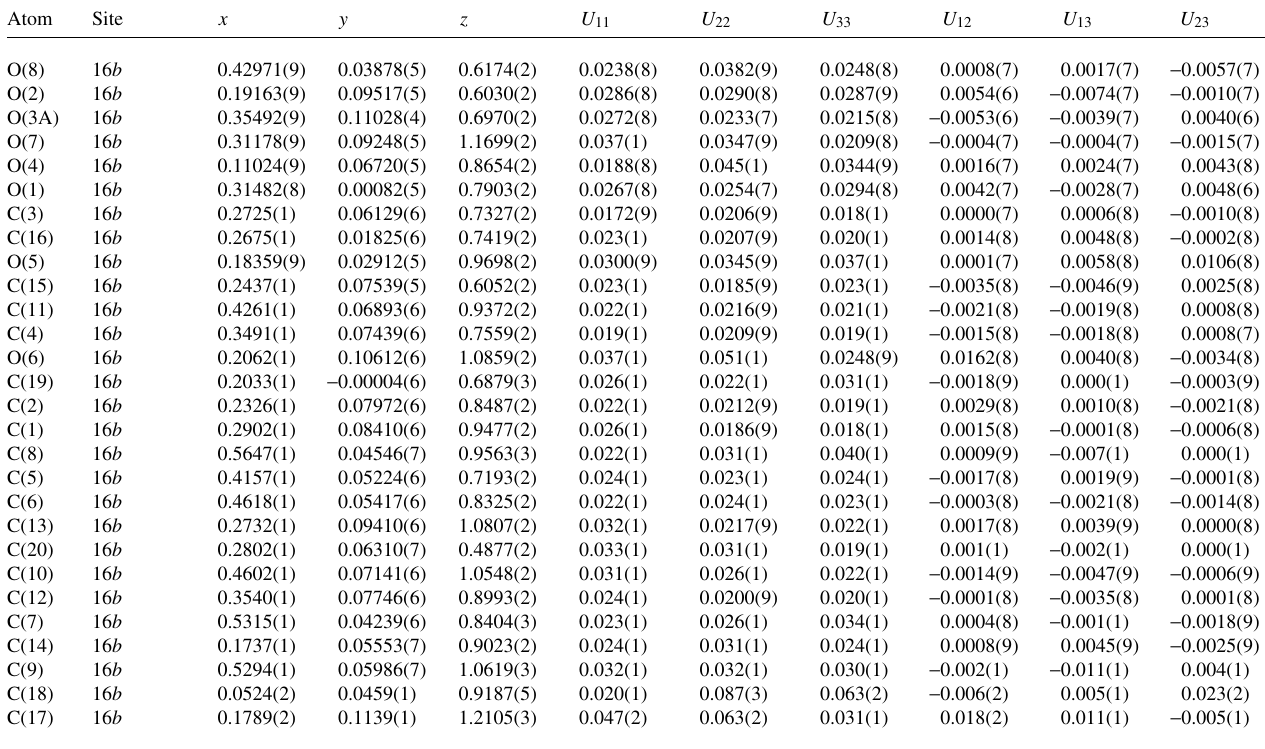
Table 3. Atomic coordinates and displacement parameters (in Å 2 ) .